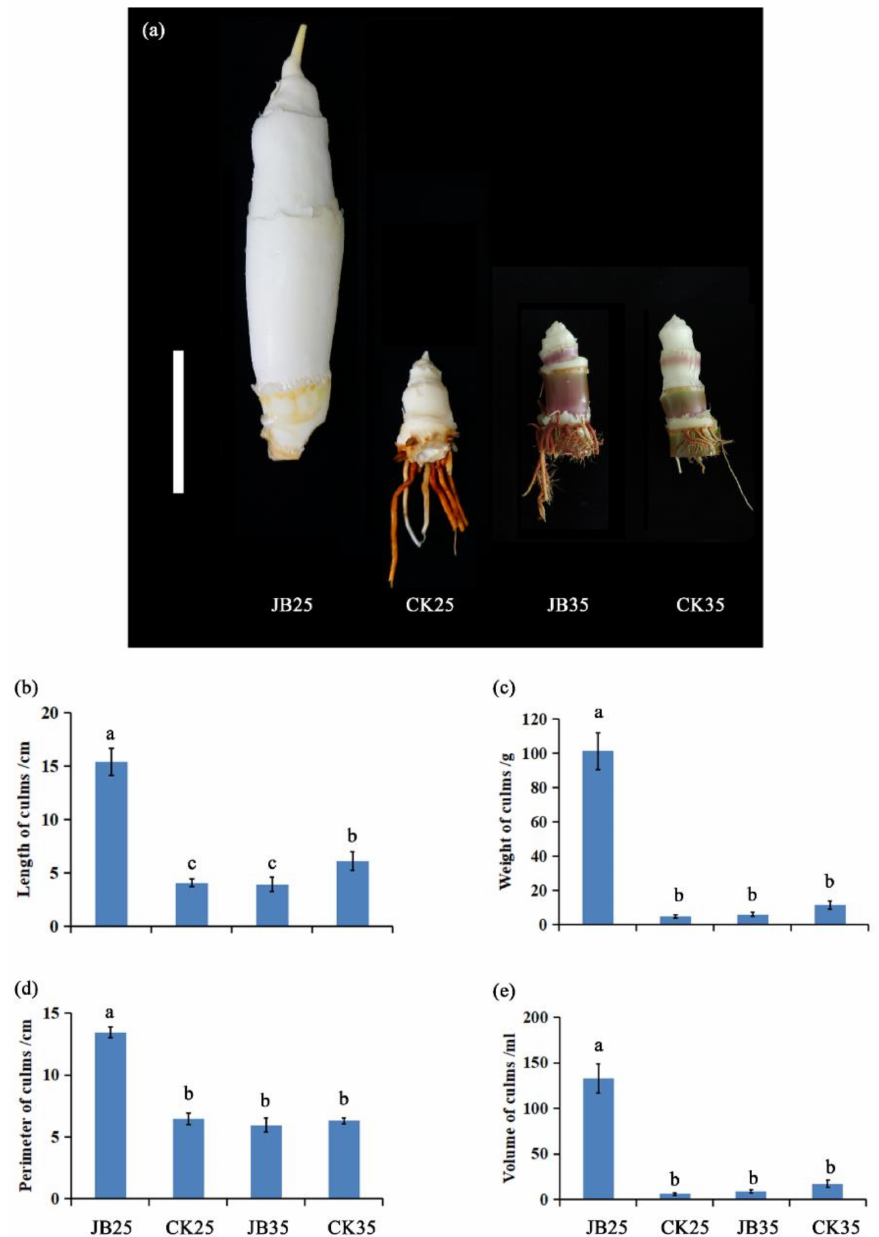
Figure 1. Morphology of Zizania latifolia culms. ( a ) Symptoms of culms; scale bar = 5 cm. ( b ) Length of culms. ( c ) Weight of culms. ( d ) Perimeter of culms. ( e ) Volume of culms. JB25 and JB35 represent culms of Z. latifolia plants infected with Ustilago esculenta grown at 25 ◦ C and 35 ◦ C, re-spectively. CK25 and CK35 represent culms of Z. latifolia plants without U. esculenta infection grown at 25 ◦ C and 35 ◦ C, respectively. Significant differences between treatments were analysed using Tukey’s multiple com-parison test ( p <